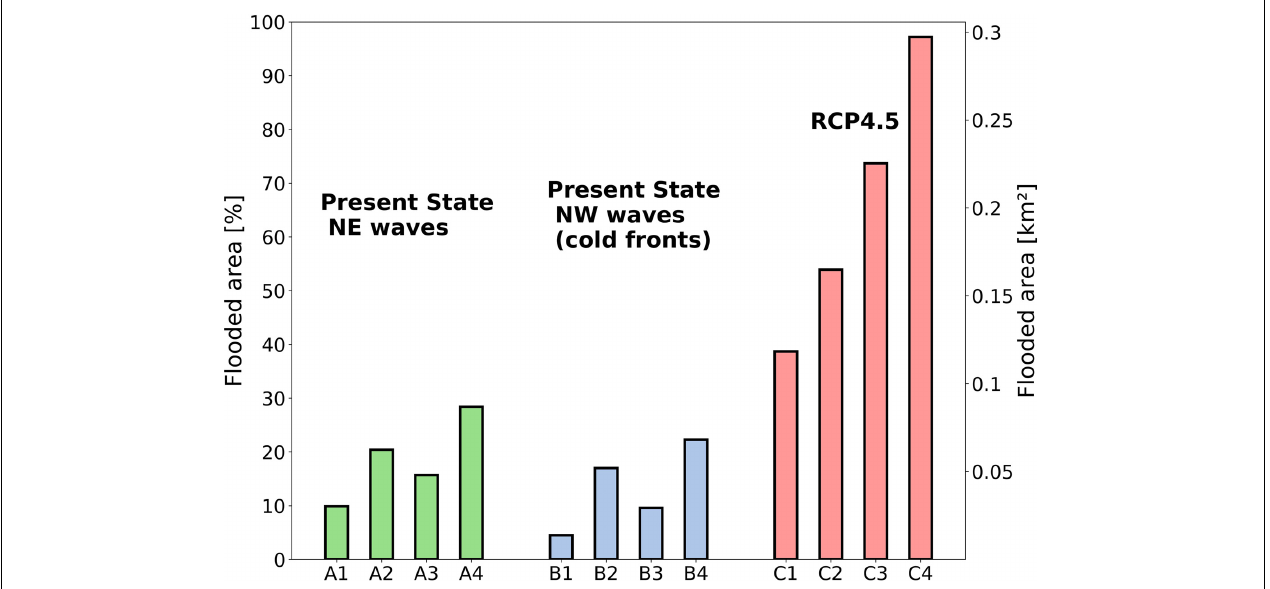
FIGURE 10 | Summary of flooded area results (left y -axis in percentage; right y -axis in total surface in km 2 ) for NE and NW coming waves under present-day conditions ( A1–A4,B1–B4, respectively), and under SLR considering the projected sea level under the RCP 4.5 W/m 2 pathway (C1–C4) . See wave set-up and properties used in the simulations in Table 2